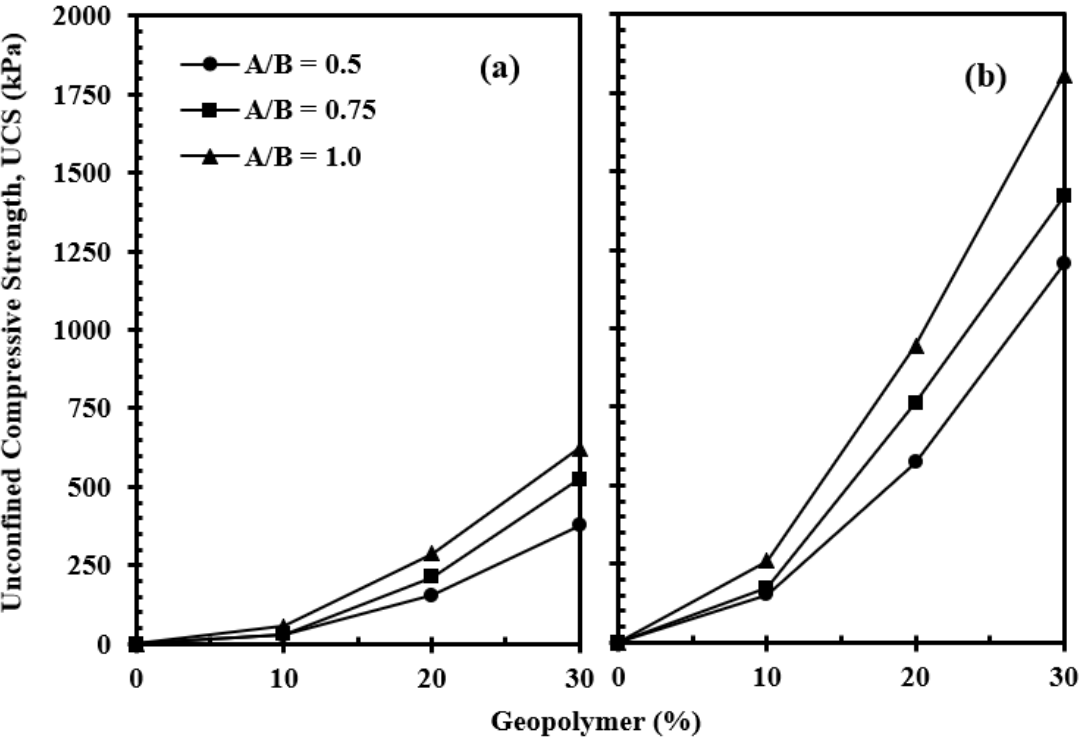
Figure 5. Effect of activator to binder ratio (A/B) on peak strength of clay at different curing periods: ( a ) 7 days and ( b ) 28 days.